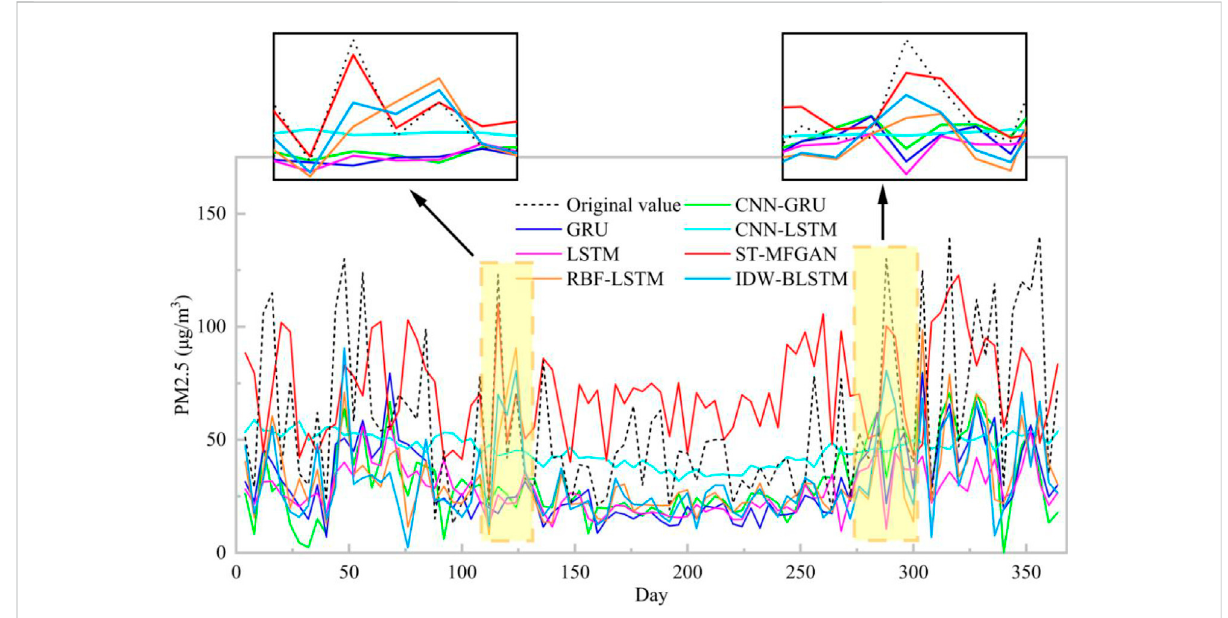
FIGURE 6 Experimental results of different methods on the Baoding test